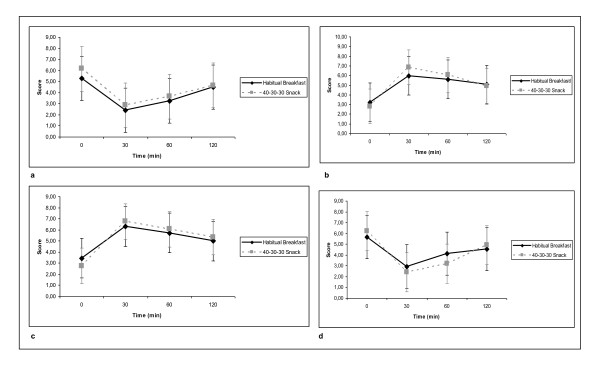
VAS postprandial questionnaire results. 2(a). Hunger score; 2(b). Satiety score; 2(c). Satisfaction score; 2(d) Intake score.